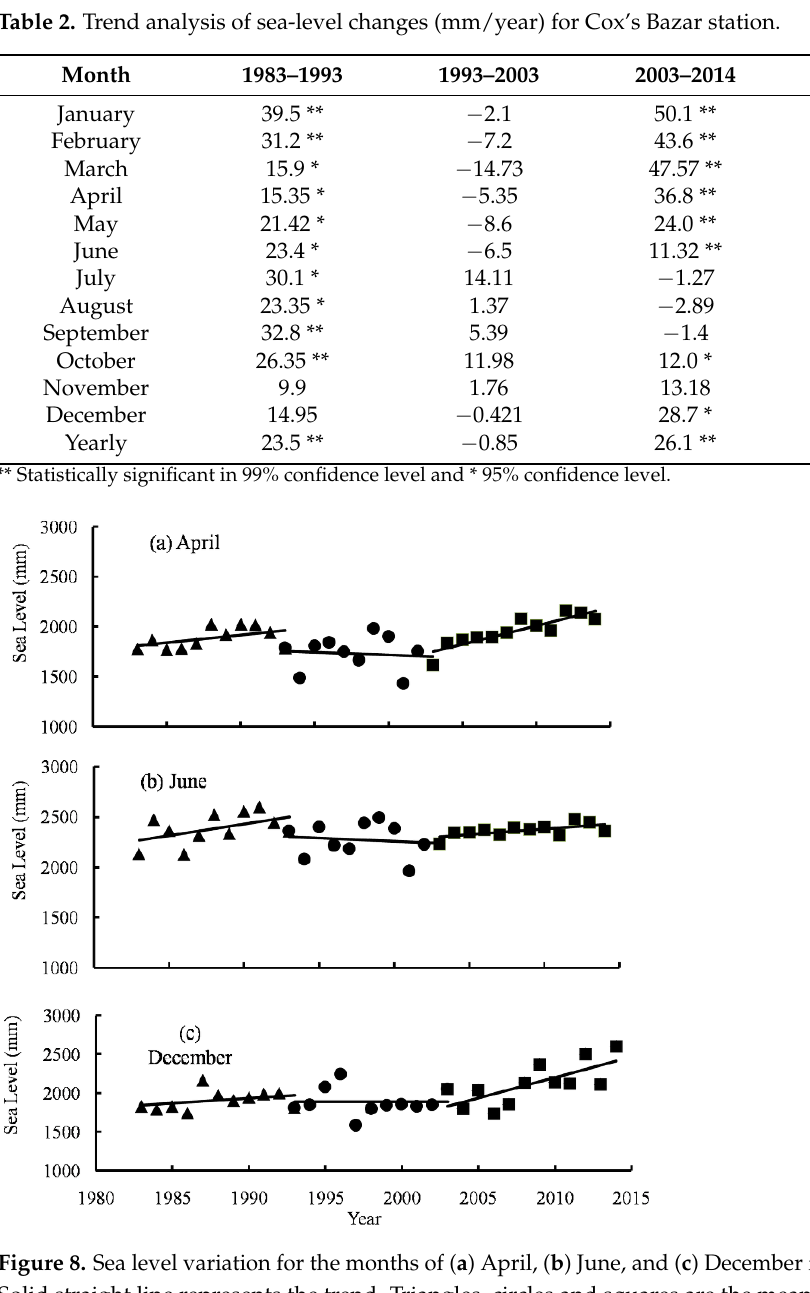
Table 2. Trend analysis of sea-level changes (mm/year) for Cox ’ s Bazar station.